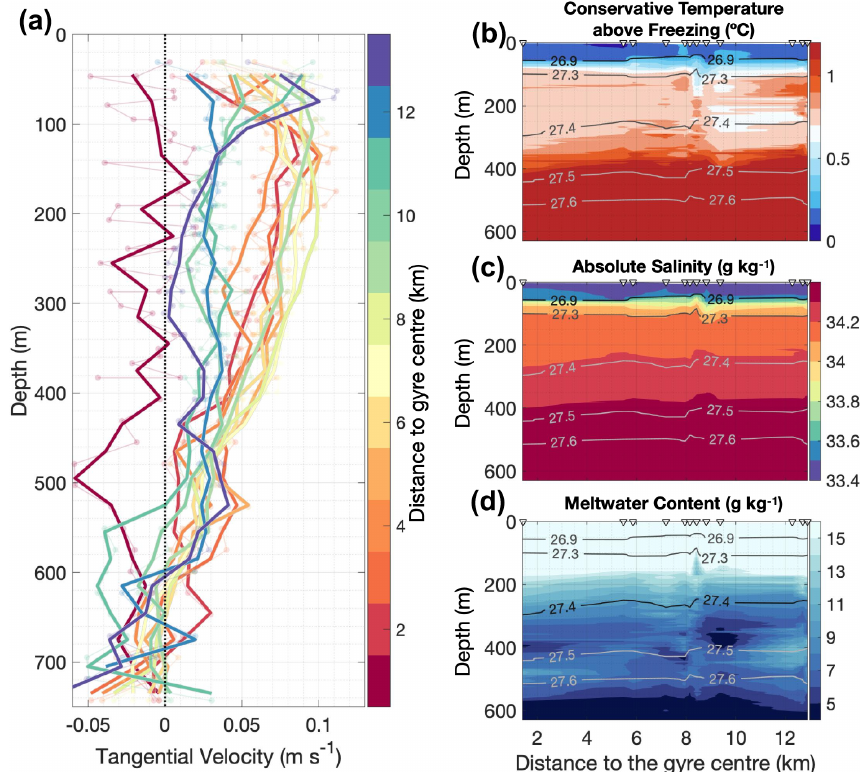
Figure 3. Vertical structure of the Thwaites gyre. (a) Tangential velocity of the Thwaites gyre with distance to the gyre centre (colours). All velocity profiles are horizontally averaged into 1km radius bins (pale dots and lines) and then vertically averaged into 30m bins (thick lines). (b–d) Section plots of CTD measurements collected in the Thwaites gyre region, with distance to the gyre centre. Potential-density isopycnals (in kgm − 3 ) are denoted by grey contours. Positions of profiles are marked as triangles at the top of the panel. Below 650m, the water column is occupied by modified Circumpolar Deep Water and is very stable so is not presented here. Conservative temperature above freezing is presented in (b) . Absolute salinity is presented in (c) . Meltwater content is presented in (d)